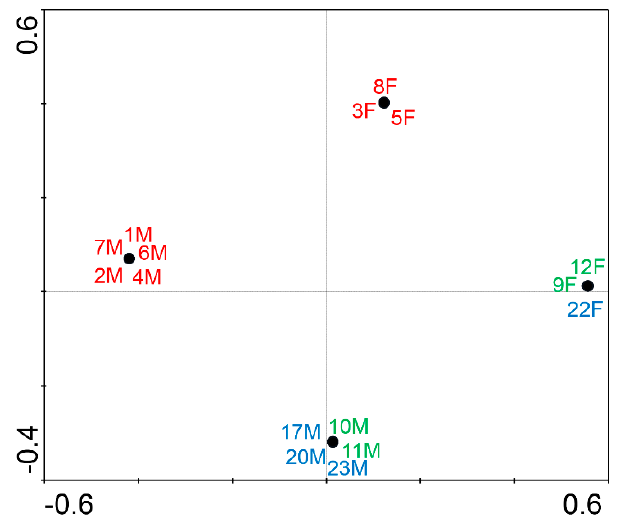
Figure 3. Redundancy analysis (RDA) of Pelophylax perezi skin bacterial samples, based in the differences between metal-contaminated and reference sites and between male and female frogs’ microbial communities. CF (3F, 5F, 8F), CM (1M, 2M, 4M, 6M, 7M), RF (9F, 12F, 22F), RM (10M, 11M, 17M, 20M, 23M). M = male frogs, F = female frogs. Red numbers indicate samples from AF (metal-contaminated) site, green numbers from BR sites and blue numbers from LC site, both reference sites.